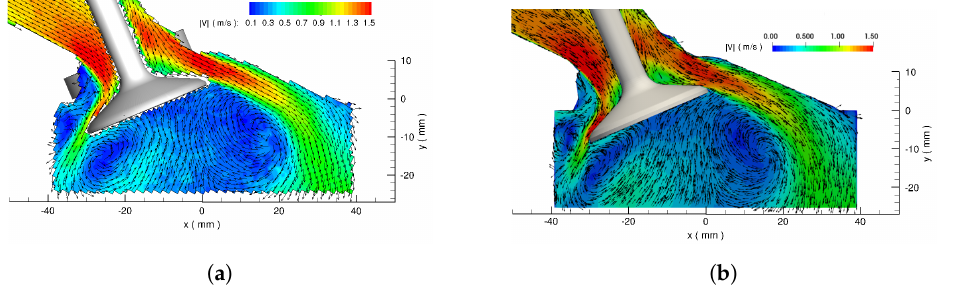
Figure 6. Comparison of velocity contour across mid-valve position in tumble plane ( Z = 19 mm): velocity evolution in intake-valve-passage and engine-cylinder. ( a ) MRV [15]; ( b ) LES-WALE.